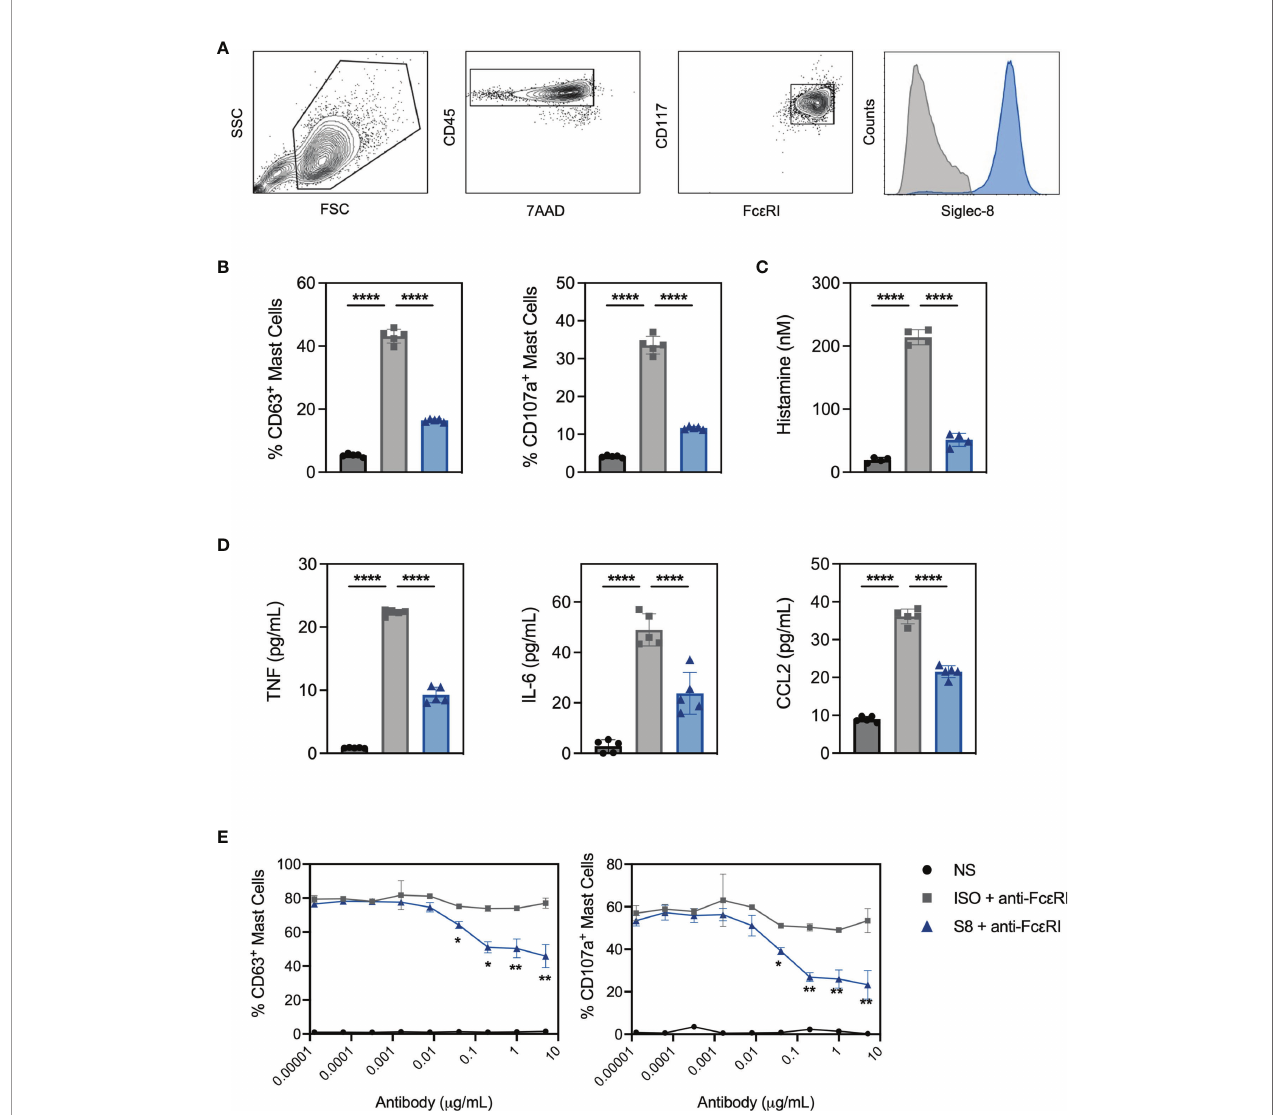
FIGURE 1 | BMMC from transgenic mice respond to Fc e RI activation and express functional Siglec-8. (A) BMMC-S8 fl ow cytometry gating strategy. Right panel represents Siglec-8 staining (blue) and FMO stain (grey) (B) Levels of surrogate degranulation markers CD63 and CD107a on the cell surface of unstimulated MC (NS; black bars), when cross-linked with the anti-Fc e RI antibody MAR-1 for 15 min (ISO + anti-Fc e RI, grey bars) or co-cross-linked with MAR-1 and Siglec-8 mAb (S8 + anti-Fc e RI, blue bars). (C) Histamine concentrations in the culture medium of MC collected 1 hour after stimulation as in (B) . (D) Cytokine concentrations in the culture medium of MC collected 6 hours after stimulation. (E) Titration of isotype control mAb and Siglec-8 mAb in combination with anti-Fc e RI-mediated (MAR-1) activation. Left panel: % of CD63 positive MC. Right panel: % of CD107a positive MC. Data are plotted as mean ± SEM (n=5) and are representative of 5 experiments. *p < 0.05, **p < 0.01, ****p < 0.0001 by one-way ANOVA test (B – D) or unpaired t test (E)